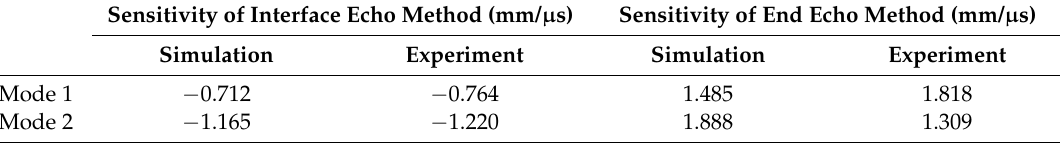
Table 2. Sensitivities of liquid-level